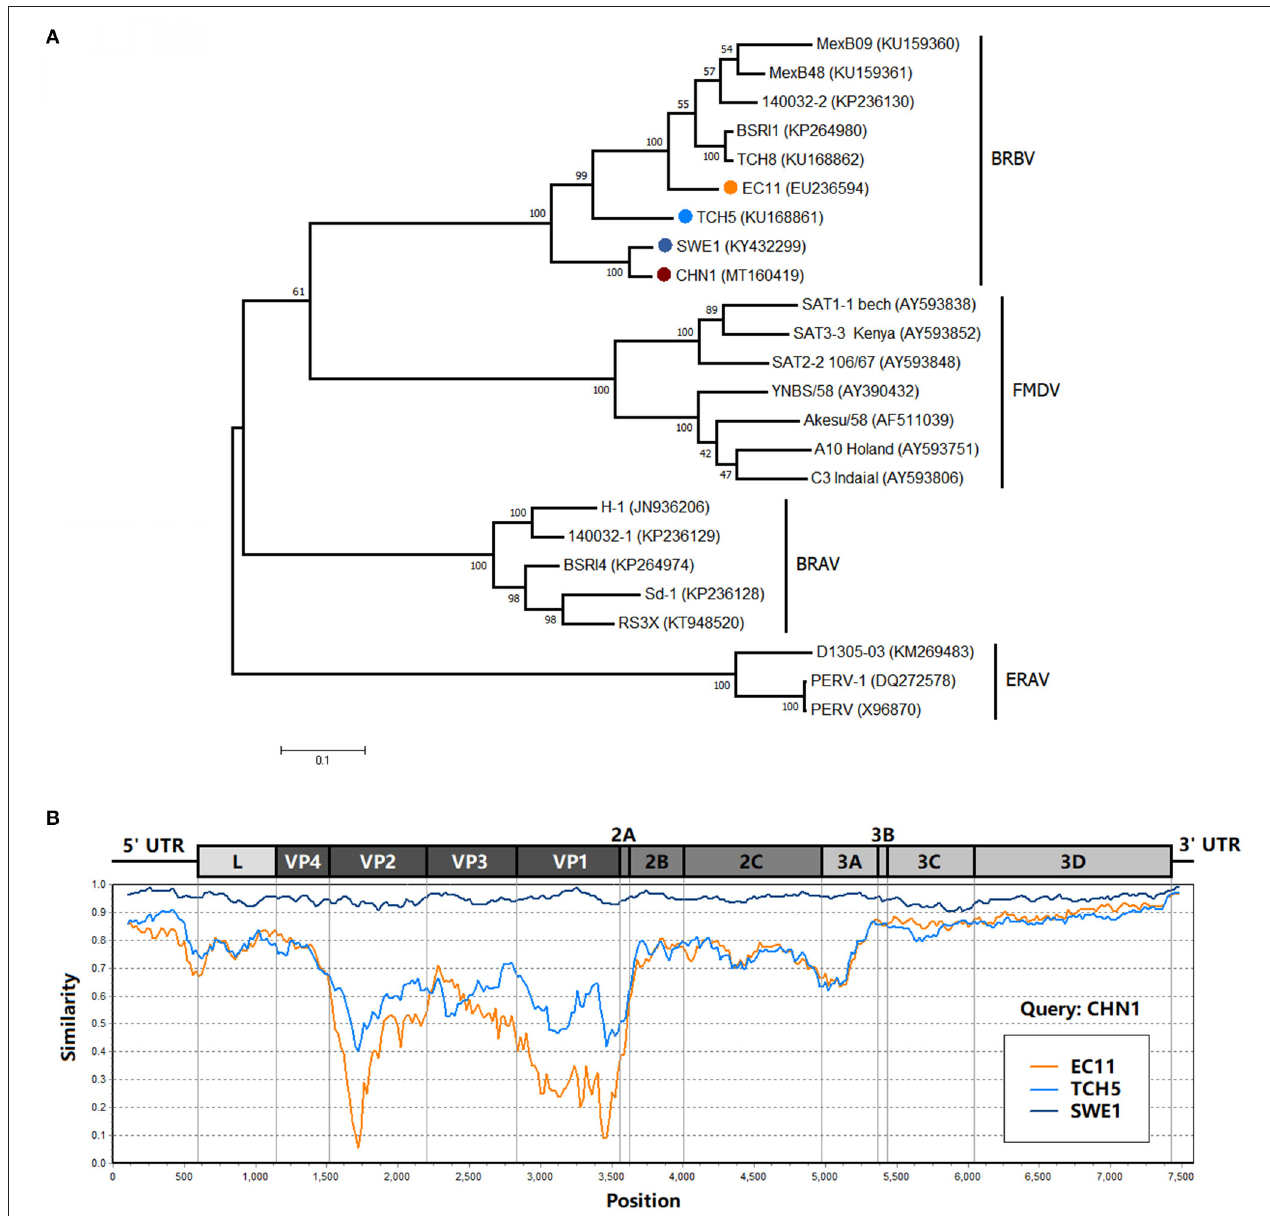
FIGURE 2 | (A) Phylogenetic analysis of BRBV polyprotein sequence with other viruses from the genus Aphthovirus. The phylogenetic tree was drawn to scale using the Maximum Likelihood method and tested with the booststrap method at a replication of 1,000, and its frequency was marked at the nodes. The isolate CHN1 that was identified in this study was marked in bold and accompanied by a red circle. (B) Similarity analysis of isolate CHN1 with isolates EC11, TCH5, and SWE1 using the Kimura (2-parameter) distance model with a 200-bp window and 20-bp step. The genomic region scale was illustrated according to isolate